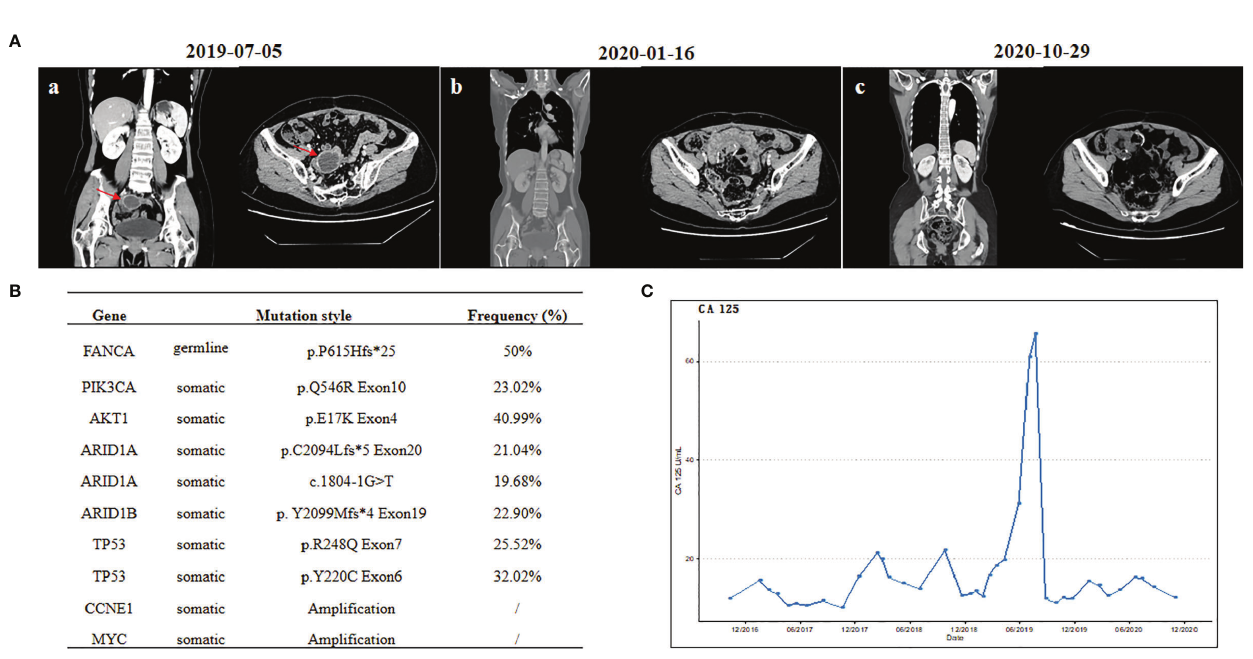
FIGURE 1 | (A) Computed tomography scans: (a) before cytoreductive surgery, (b) before niraparib treatment, and (c) after 9 months of niraparib treatment. (B) List of deleterious or likely deleterious somatic variations by next-generation sequencing in ovarian carcinoma. (C) Changes of serum tumor marker levels of carbohydrate antigen